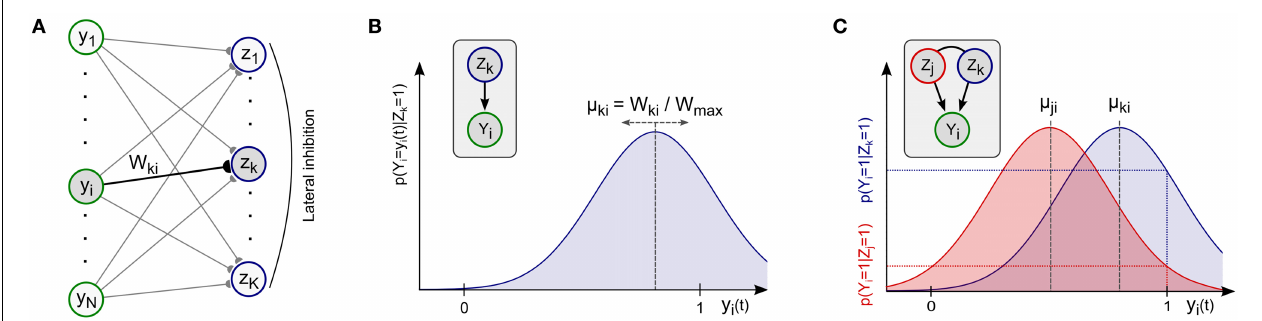
synapse, i.e., stronger synaptic weights W ki correspond to higher mean values μ ki . Inset: Local implicit graphical model. (C) Illustration of Bayesian inference for two competing network neurons z k , z j and one active input y i ( t ) = 1. Different means μ ki , μ ji encoded in the weights give rise to different values in the likelihood function and shape the posterior distribution according to Bayes